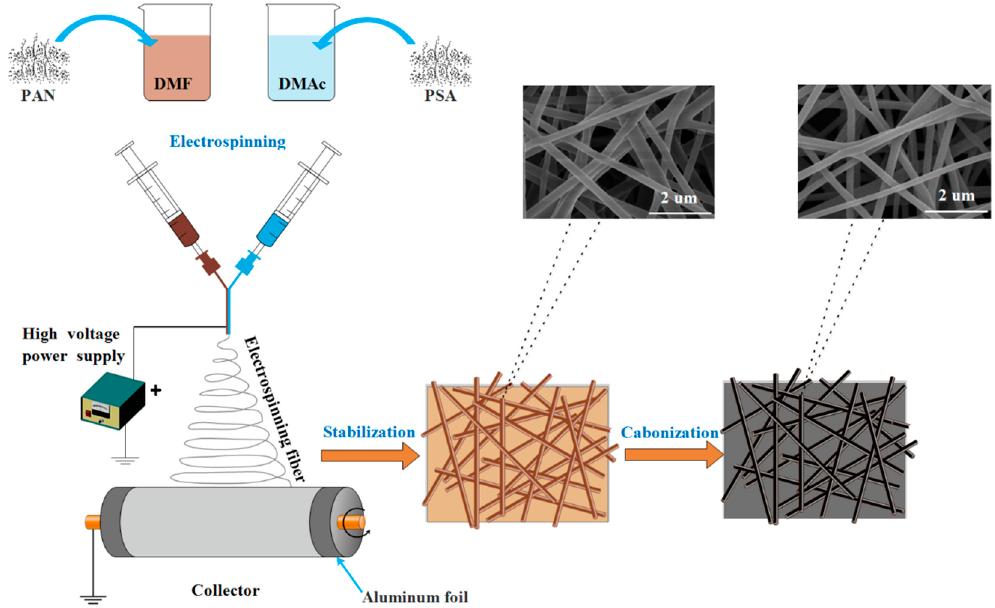
Figure 2. Schematic illustration of the system and the forming of carbonized nanofibers.